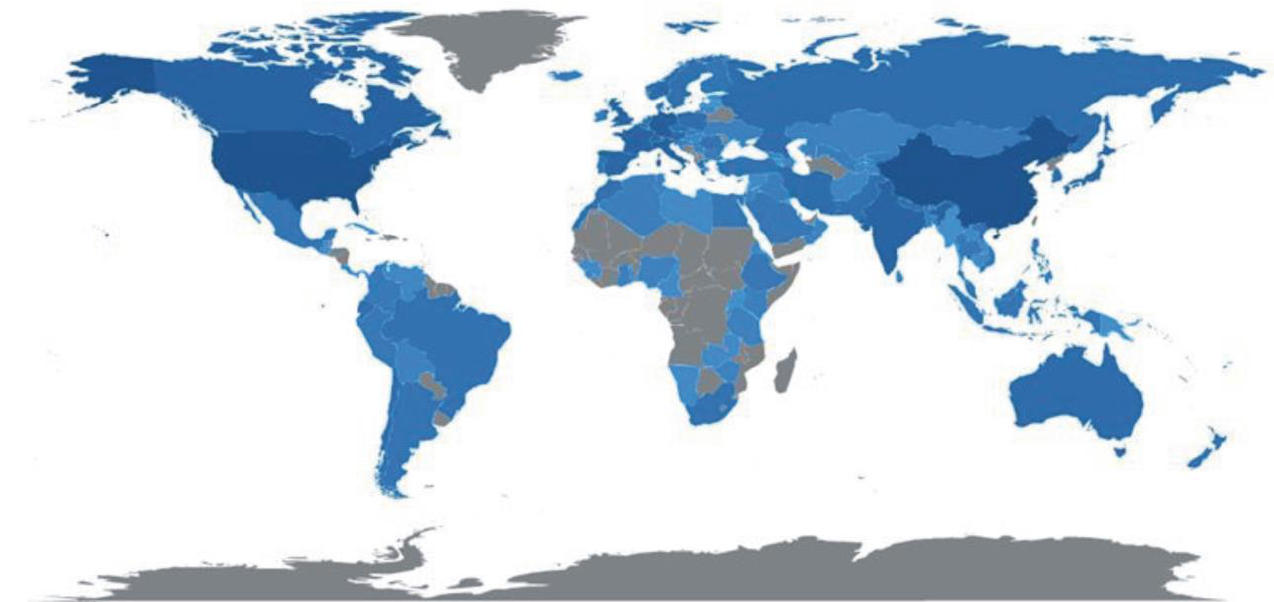
Figure 3. The global distribution of publications in this study. Top 20 articles cited, corresponding author’s name, year, title, source, total cita- tions (TC), and total citations per year (TCpY)on the application of remote sensing methods in mountainous